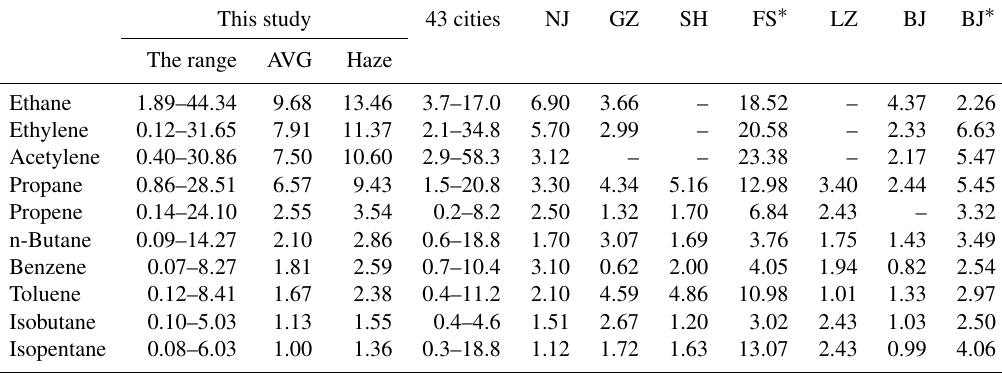
Isopentane The 43 cities in China from January to February 2001 (Barletta et al., 2005): NJ, Nanjing, March 2011–February 2012 (An et al., 2014); GZ, Guangzhou, June 2011–May 2012 (Zou et al., 2015); SH, Shanghai, December 2006–February 2007 (Song et al., 2012); FS,